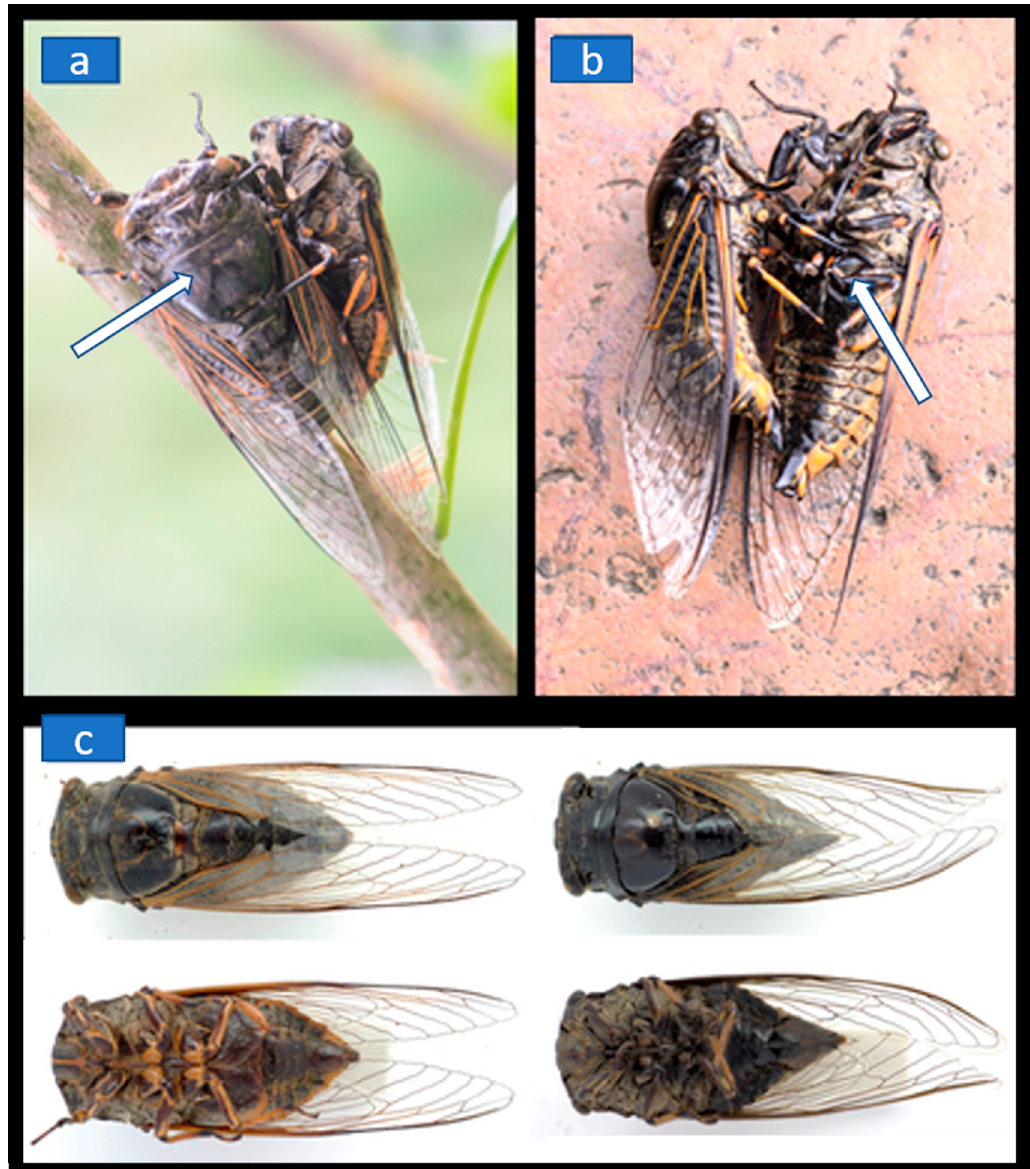
Figure 1. Two male Cryptotympana atrata cicadas engaged in mating on a branch ( a ) and then placed on a stone for closer inspection especially of the male genitalia ( b ). The white arrow points to the dead male. ( c ) The upper row shows the dorsal side of a male (left) and female (right), while the bottom row shows the corresponding ventral sides. According to Hayashi [6] the species is very variable and geographic and/or individual variations within C. atrata exist. Body lengths for both genders have been reported to be 36–46 mm (females are often slightly larger than males).